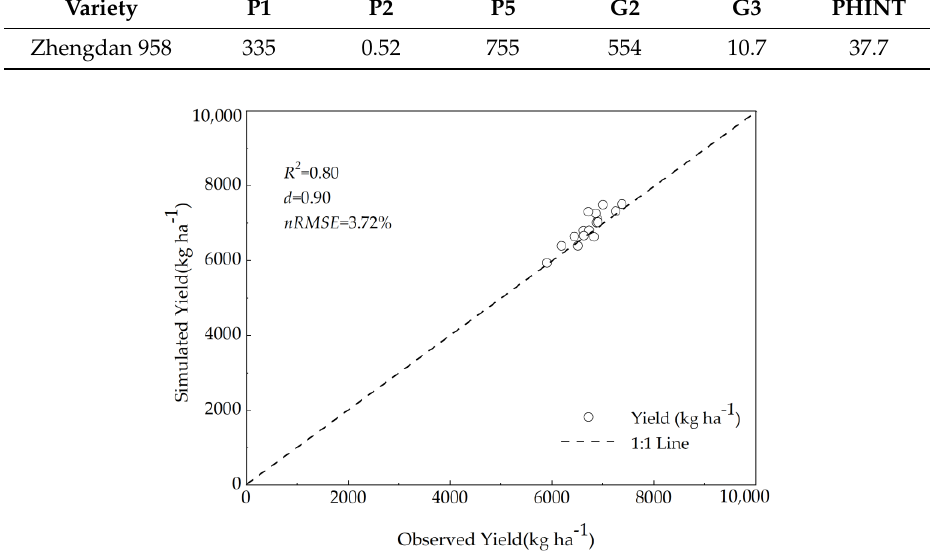
Figure 4. Relationships between simulated and observed yields of summer maize under different treatments at Wugong County.